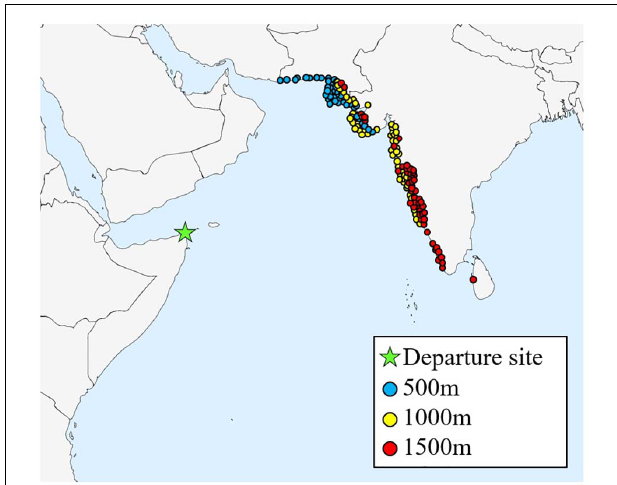
FIGURE 9 | Map showing arrival sites for all successful spring trajectories ( N = 150), for each starting height (500, 1,000, and 1,500 m), for the departure site Guardafui lighthouse, Somalia.